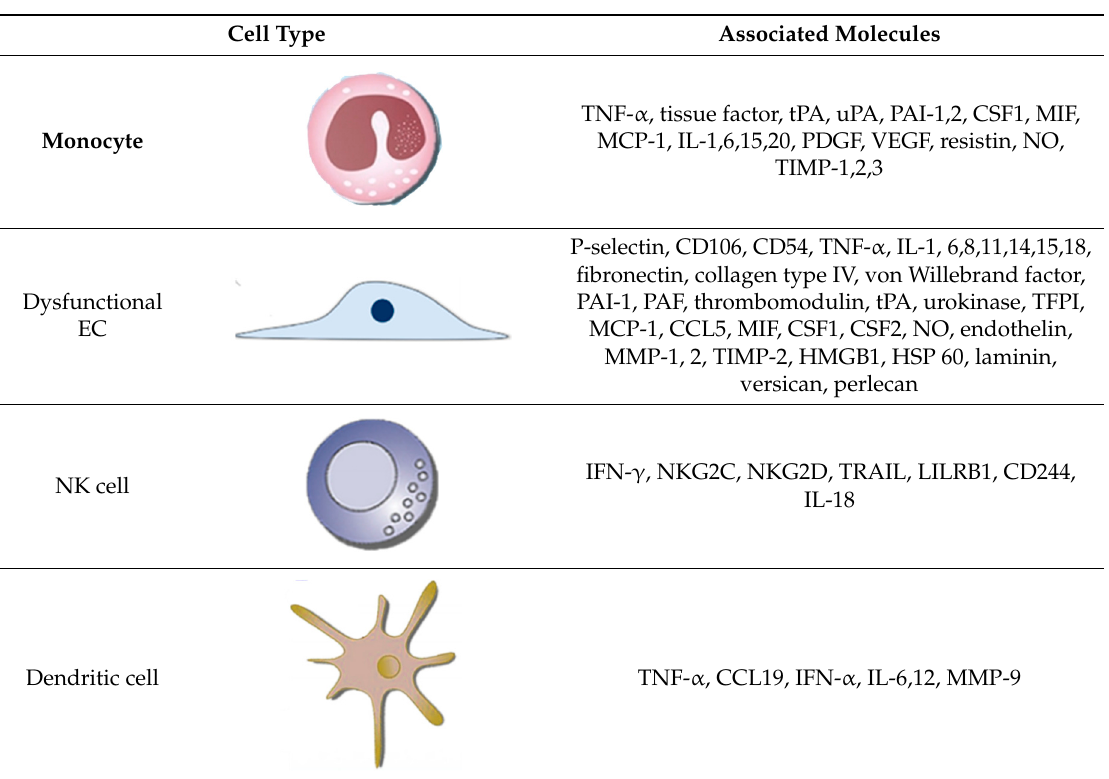
Table 1. Expression of molecules in the course of atherosclerotic plaque development.